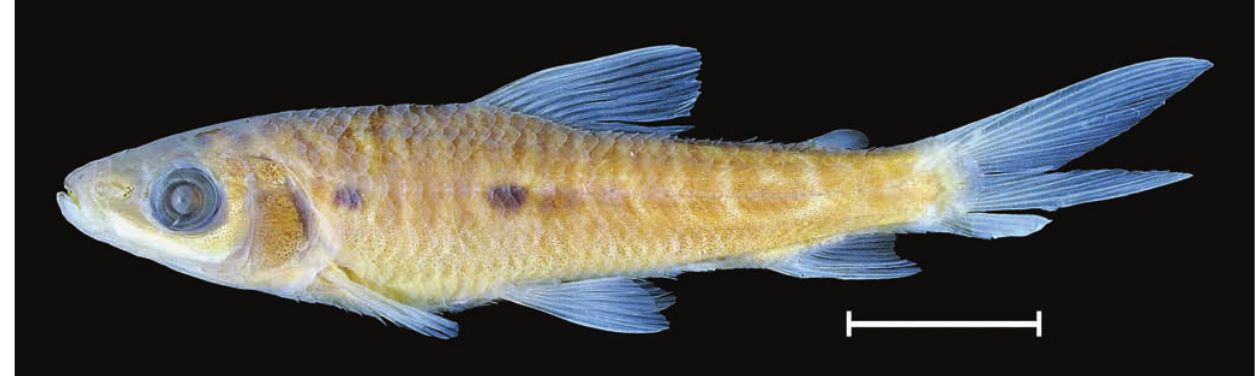
Fig. 5. Leporinus amazonicus , MZUSP 77507, 43.0 mm SL, rio Solimões at entrance of Lago Anauacá. Scale bar = 10 mm.